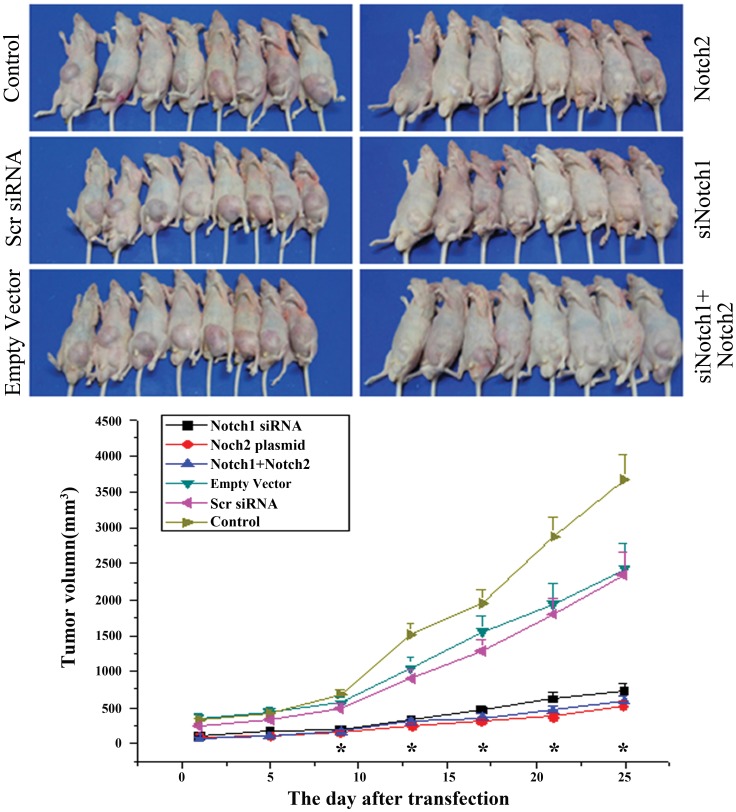

In vivo study of nude mice treated with Notch1 siRNA and Notch2 plasmid.Tumor growth in nude mice treated with Notch1 siRNA and Notch2 construct compared to that in control, scr-siRNA and empty vector treated mice. *: p<0.05.